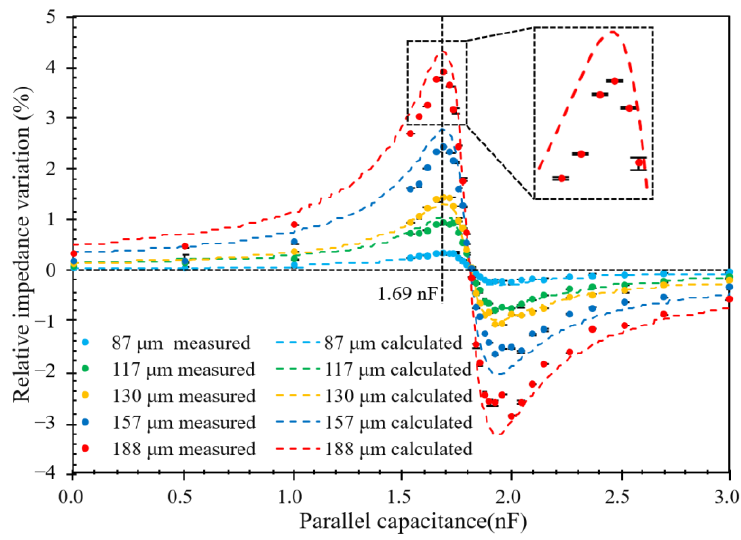
Figure 9. The relative impedance variation induced by iron particles for different capacitances.